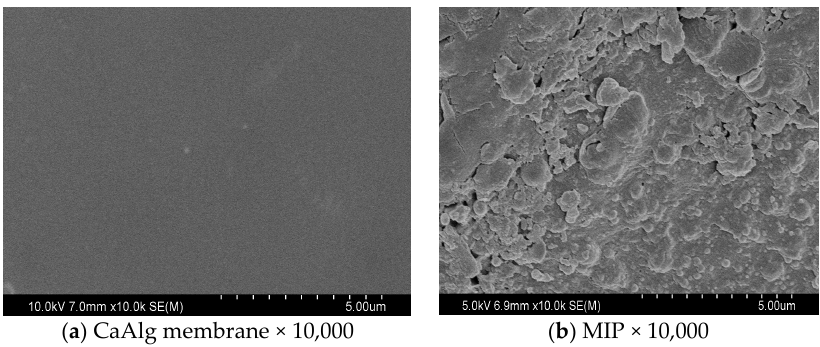
Figure 2. SEM images of CaAlg membrane ( a ) and MIP membrane ( b ).